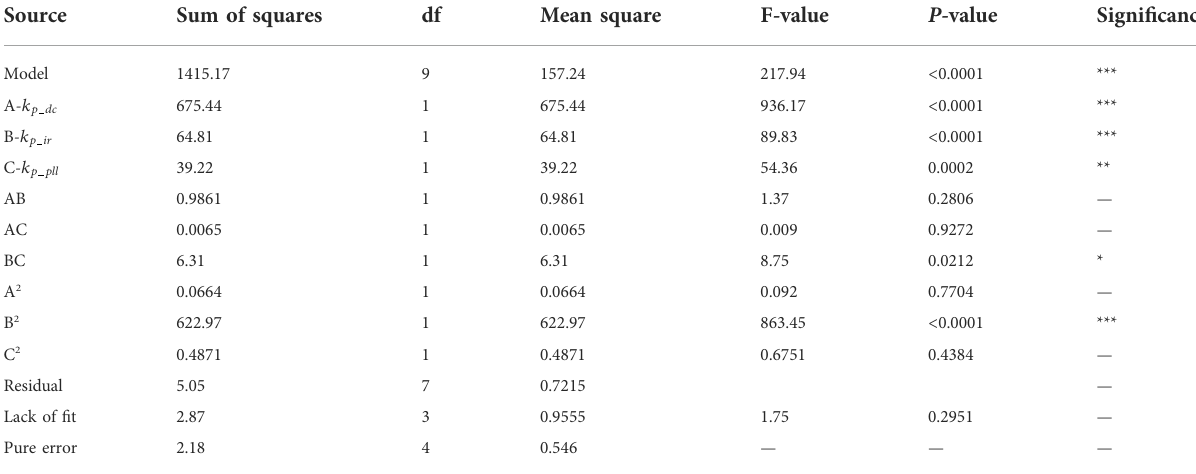
TABLE 7 ANOVA results for OD of RSM.